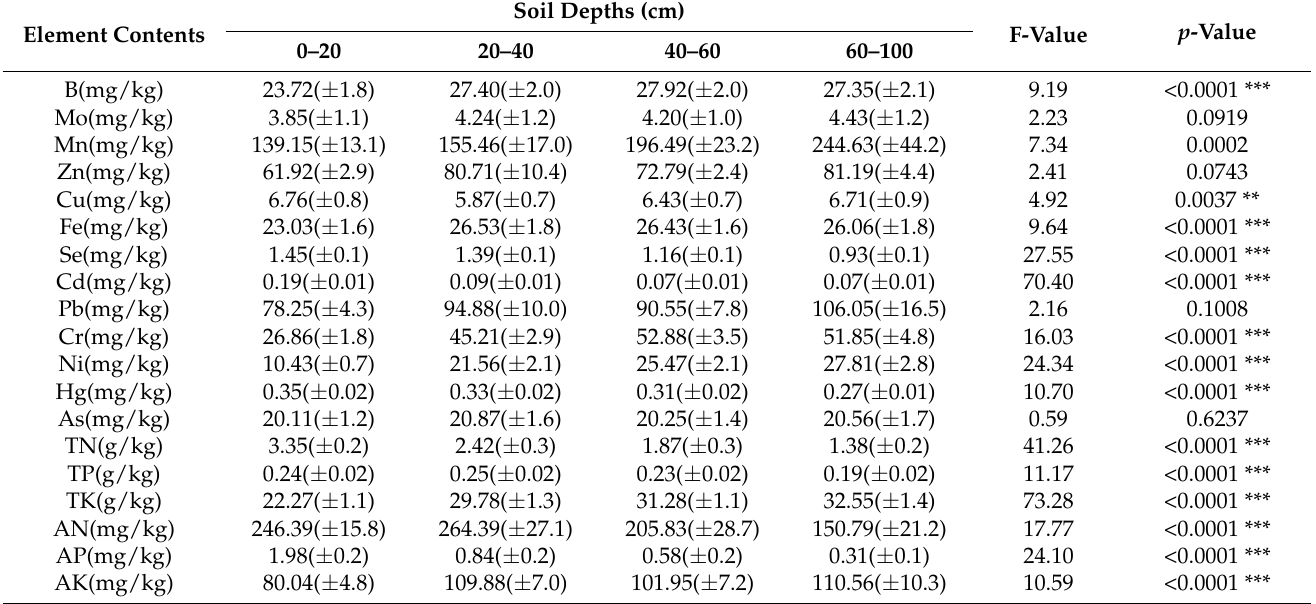
Table 1. Elemental contents in different soil